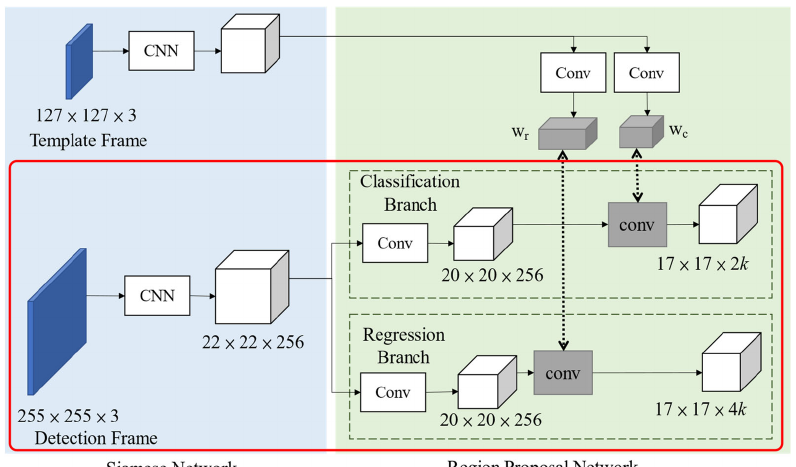
Figure 10. The tracking framework in SiamRPN.